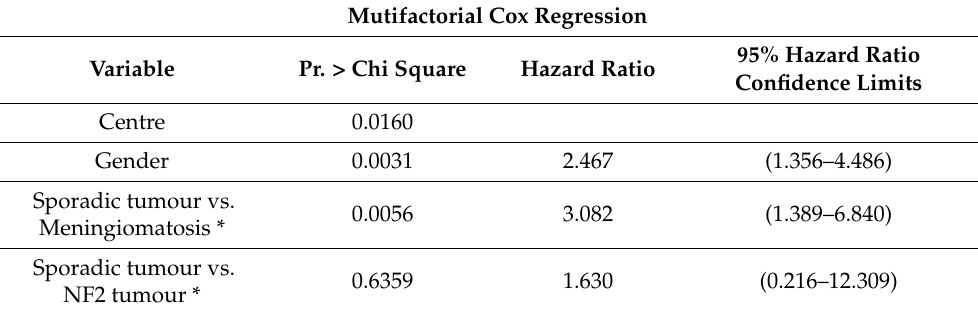
Table 5. Multivariate analysis of tumour control defined as stable or reduced tumour volume on follow-up